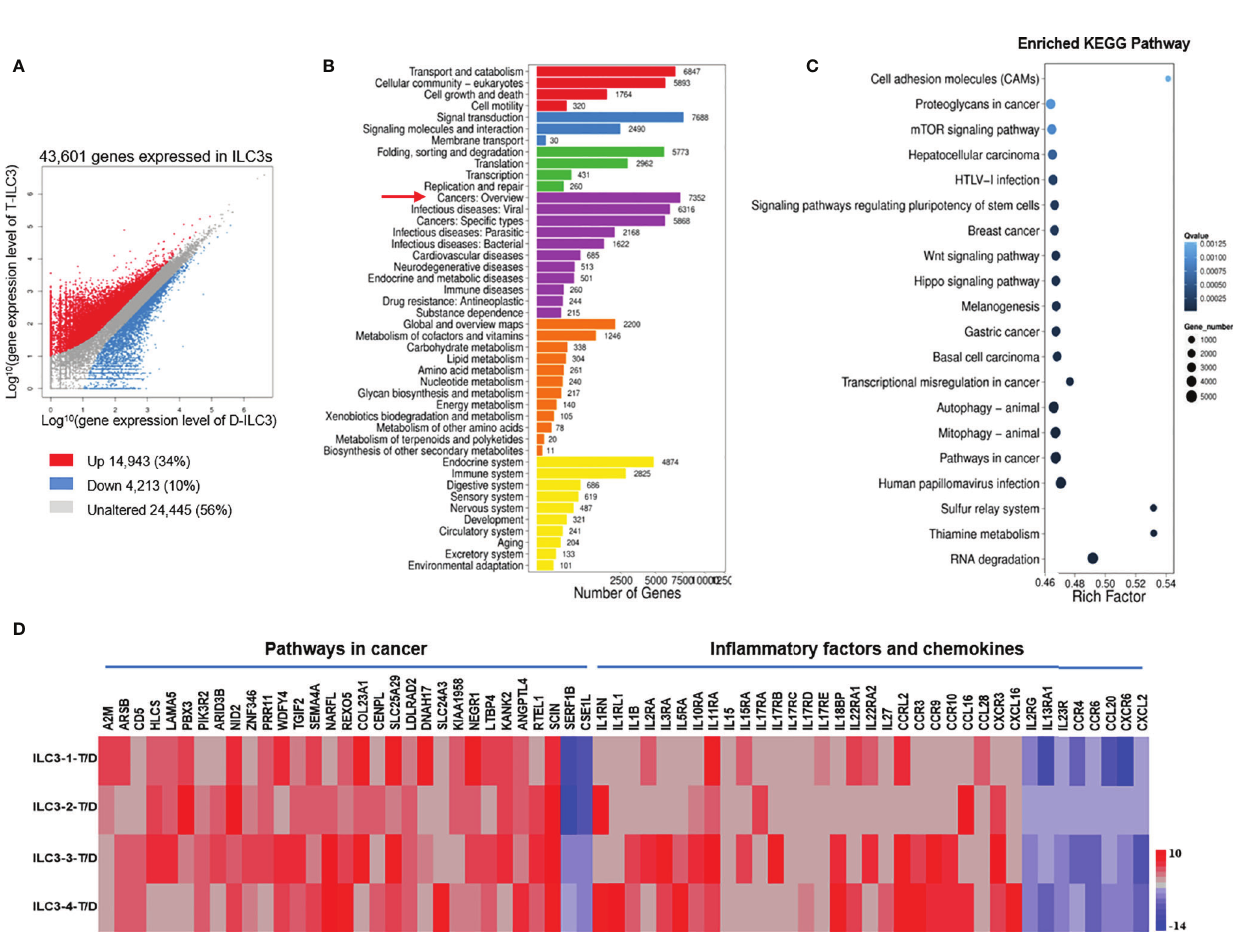
FIGURE 3 | DEGs in ILC3s are associated with both tumor development and inhibition. Analysis of gene expression in tumor and distal ILC3s and identi fi cation of signi fi cant pathways regulated by the DEGs. (A) Scatter plot of DEGs: X and Y axes represent log 10 -transformed gene expression levels. Upregulated, downregulated, and unchanged genes are presented in red, blue, and gray, respectively. (B) Pathways regulated by the DEGs: The X-axis represents the number of DEGs, whereas the Y-axis represents the functional classi fi cation. (C) Pathway functional enrichment of DEGs: The X-axis represents the enrichment factor, and the Y-axis represents the pathway name. The color indicates the q-value (high: white; low: blue). A lower q-value signi fi es a more signi fi cant enrichment. Point size indicates the DEG number. Rich Factor refers to the value of the enrichment factor, which is the quotient of the foreground value (the number of DEGs) and the background value (total number of genes). The larger the value, the more signi fi cant the enrichment. (D) RNA-Seq analysis of DEGs in tumor versus distal ILC3s. Data from four separate tumor ILC3s (T, experimental group) versus data from four separate distal ILC3s (D, control